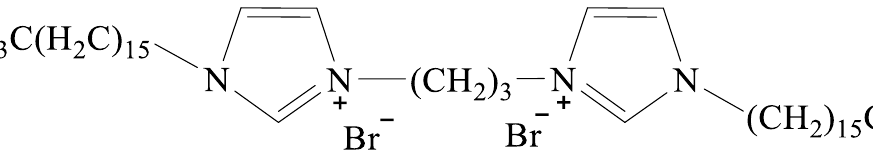
Figure 3. The molecular structure of [C 16 IMC 3 C 16 IM][Br] 2 .